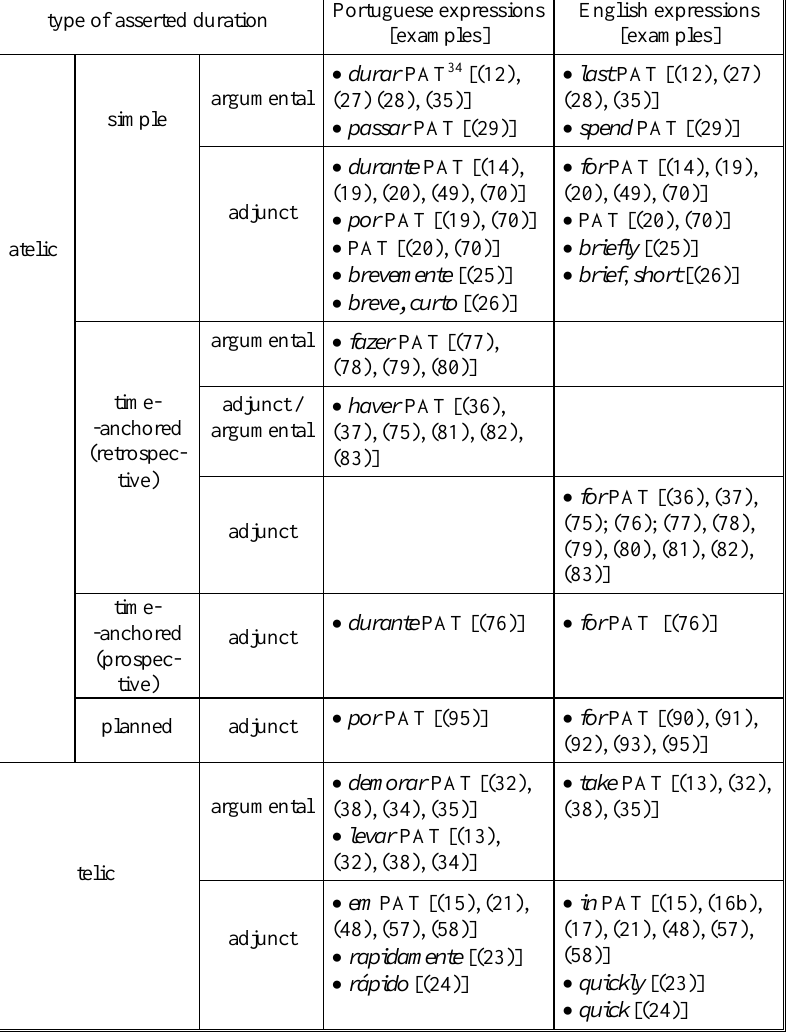
Table 4. Some outstanding types of asserted